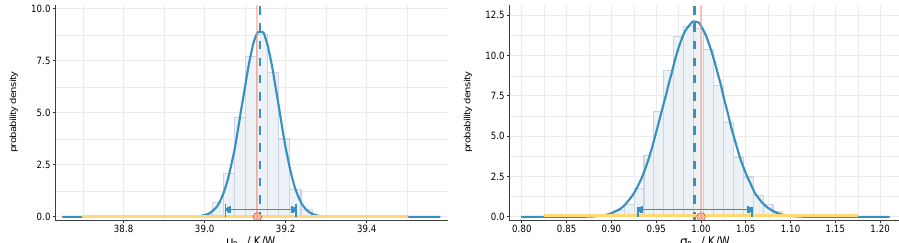
Figure 6. Posterior marginals of ( left ) µ R with 95%-HPD regions, true values (red circle) and (uniform) prior distributions (yellow